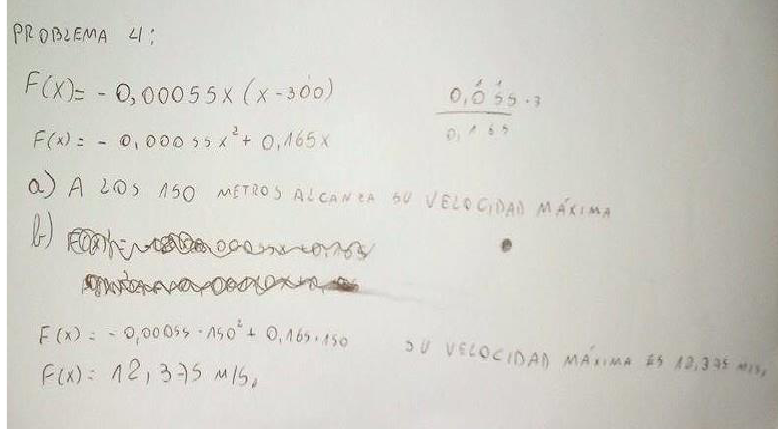
Fig. 6. Production of one